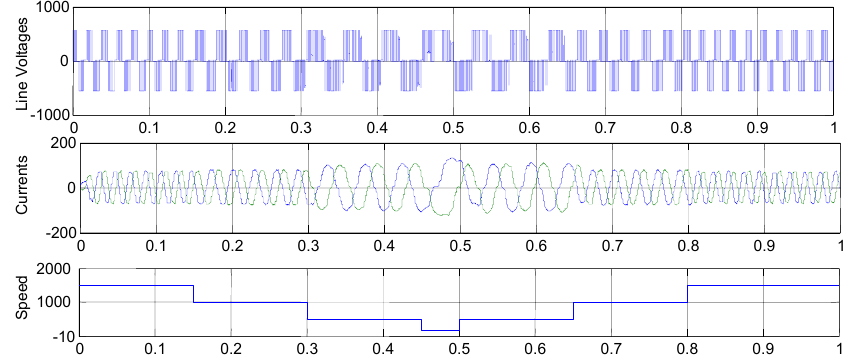
Figure 6. Effect of speed variation (decrement/increment) on voltage and current using the main battery.